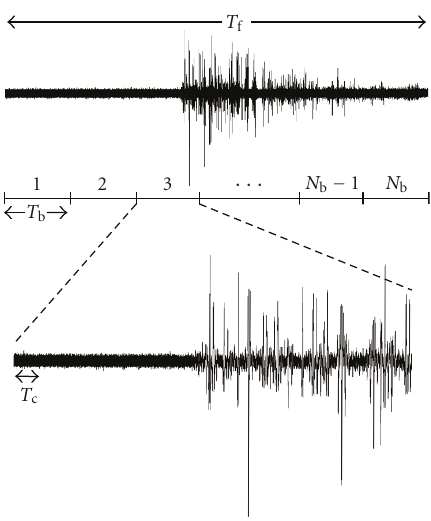
Figure 2: Illustration of the two-step TOA estimation algorithm. The signal on the top is the received signal in one frame. The first step checks the signal energy in N b blocks and chooses the one with the highest energy (although one frame is shown in the figure, energy from di ff erent frames can be collected for reliable decisions). Assuming that the third block has the highest energy, the second step focuses on this block (or an extension of that) to estimate the TOA. The zoomed version of the signal in the third block is shown on the